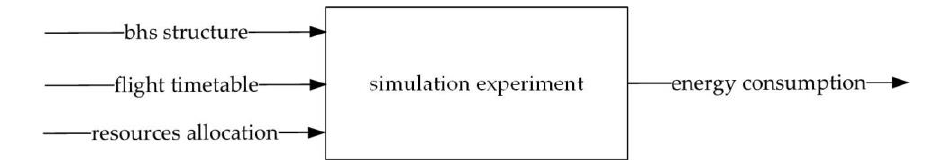
Figure 1. Simulation model